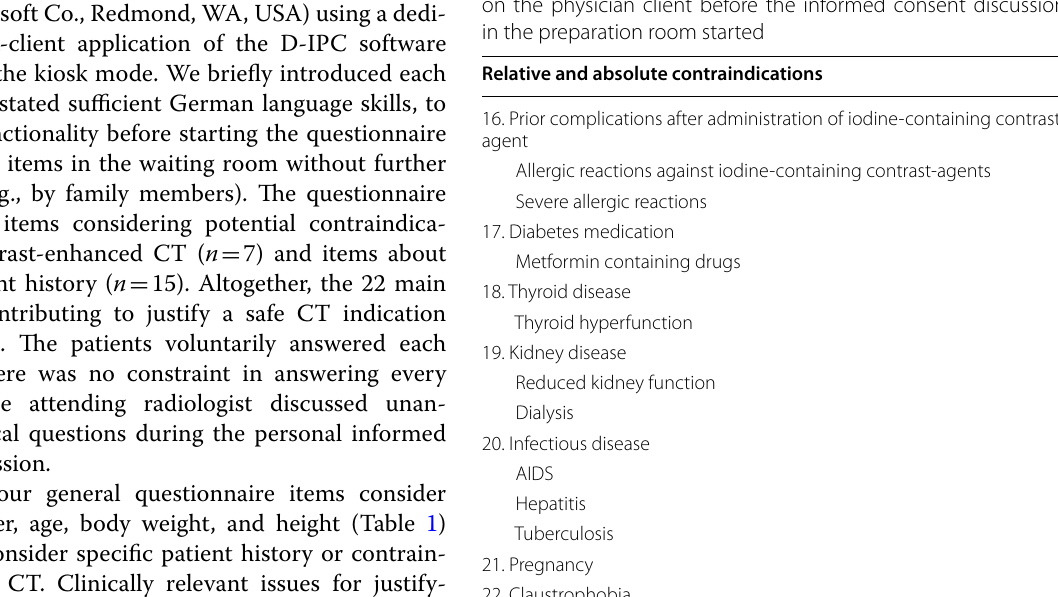
Table 2 Red flags. We considered the following items about relative and absolute contraindications as highly relevant for justifying CT indication and protocol selection. A structured and easily accessible summary of red flag information was presented on the physician client before the informed consent